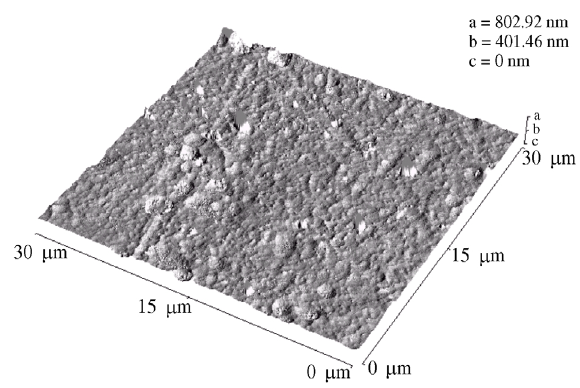
Figure 8. Atomic force micrograph for TiN film without HIP